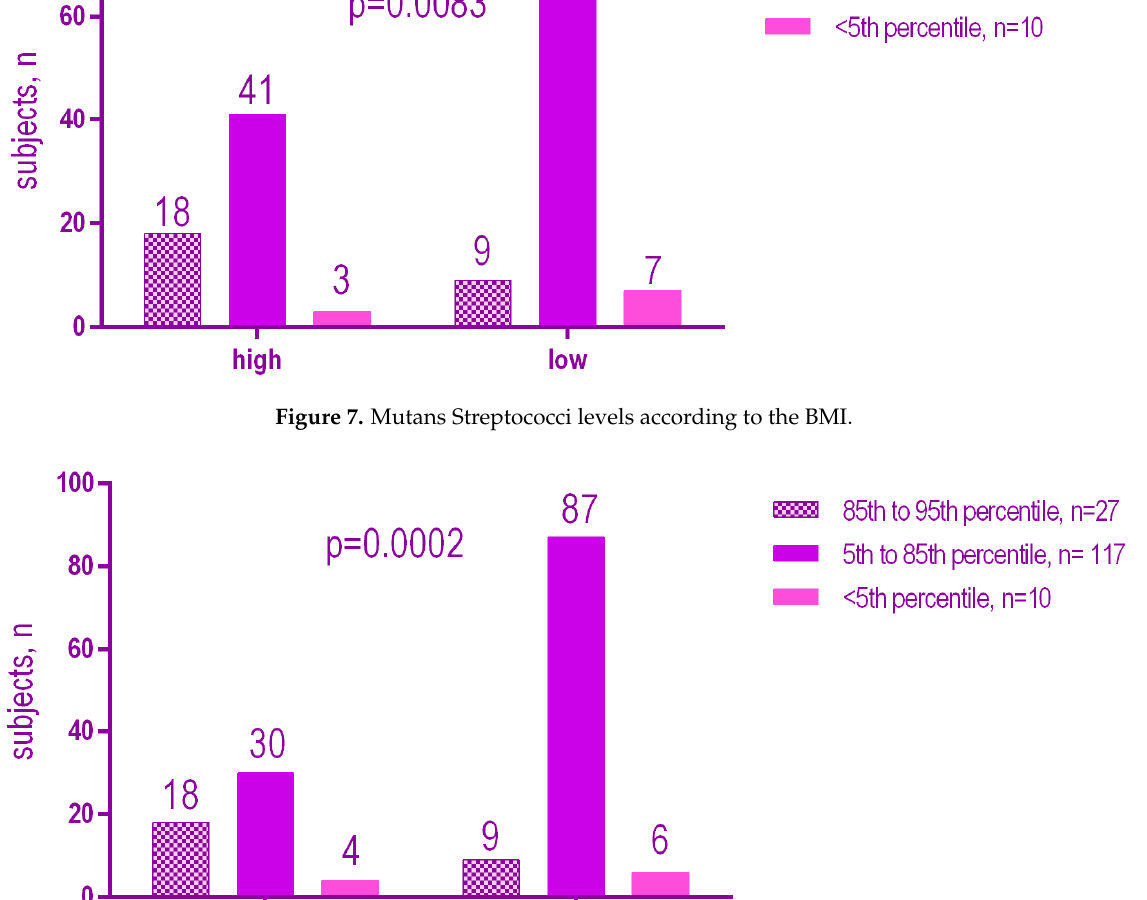
Figure 8. Lactobacilli levels according to the BMI.